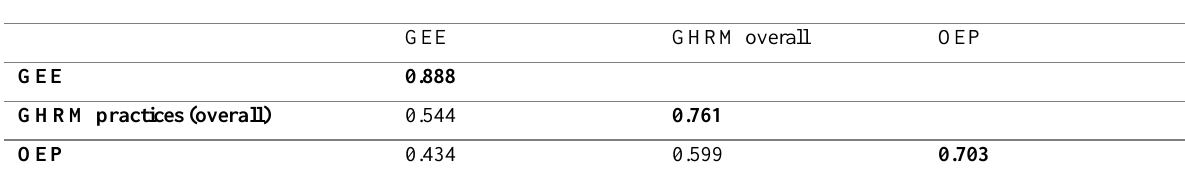
Table 3: The Fornell-Larcker